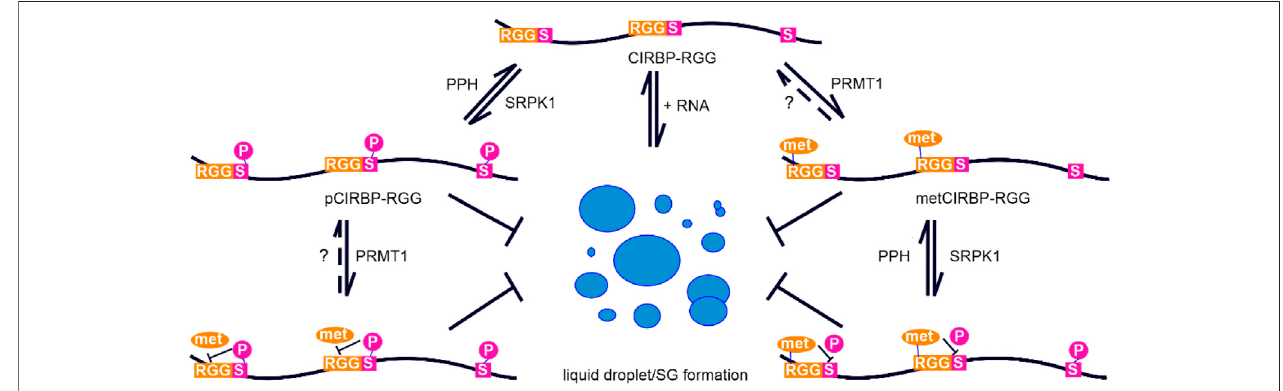
FIGURE 7 | Proposed model depicting arginine methylation and phosphorylation crosstalk in CIRBP-RGG. Graph illustrating the suppression of CIRBP-RGG invitro phaseseparationbyphosphorylationandargininemethylation,aswellasthecrosstalkbetweenargininemethylationandphosphorylationwithinCIRBPRG/RGG region.Theformationofliquiddropletsandbiomolecularcondensatesisshowninasimpli fi edmannerasbluecircles.Dottedlineandthequestionmarkindicatethelack of consensus regarding arginine de-methylation, and PPH represents protein